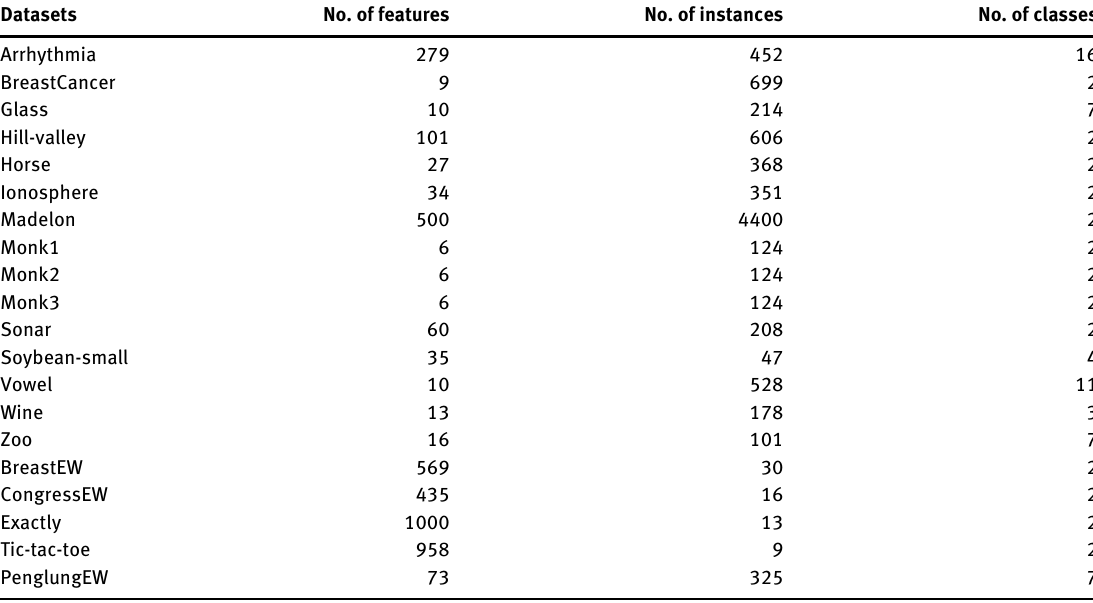
Table 2: Description of 20 UCI Datasets Used for Evaluation of the Proposed FS Method. Datasets